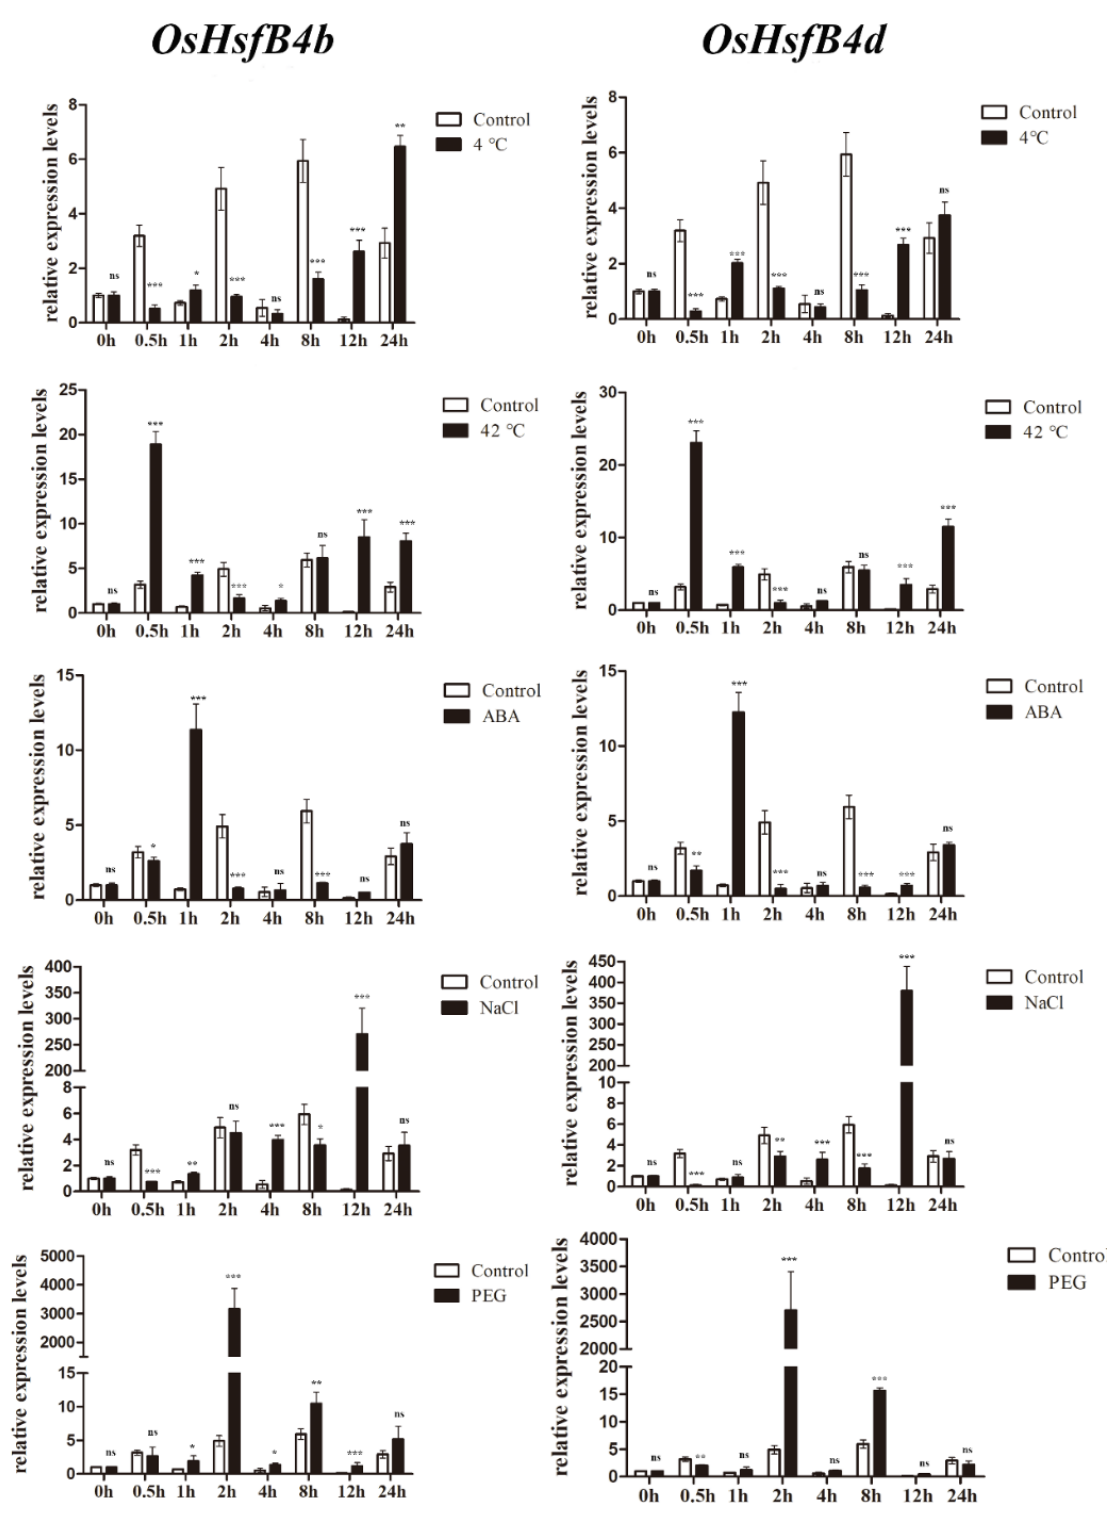
Figure 5. Expression levels of OsHsfB4d and OsHsfB4d in response to cold, heat, NaCl, ABA, and PEG treatments. Relative expression levels of OsHsfB4b and OsHsfB4d in response to drought for 1 h to 24 h in the leaves at the three-leaf stage of rice. Data were normalized to OsActin1 and OsActin2 . Values were the mean ± standard deviation of three biological replicates. ANOVA and Tukey’s test (ns inditated non-significant. * p < 0.05, ** p < 0.01, *** p <